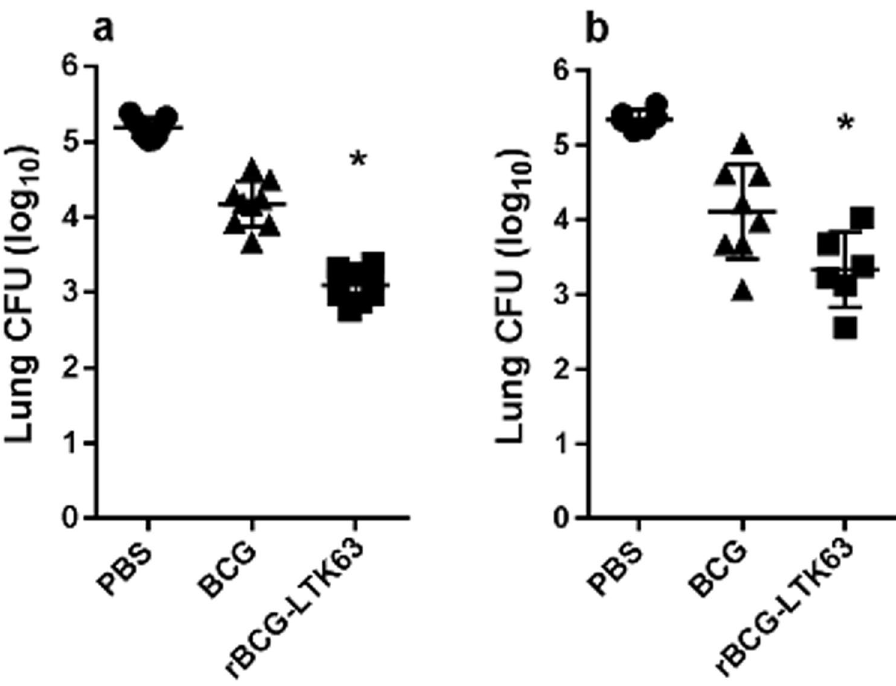
Figure 1. Protection of mice immunized with rBCG-LTK63 from Mtb challenge. BALB/c mice were immunized with BCG or rBCG-LTK63 (1 × 10 6 CFU) (s.c.) and challenged intratracheally 8 weeks later with a dose of Mtb H37Rv (1 × 10 5 CFU). Recovery of Mtb was evaluated in the lungs 30 days after challenge. ( a ) Experiment 1 (n = 10 animals) and ( b ) Experiment 2 (n = 6–8 animals). Bars are mean ± S.D. ( * )